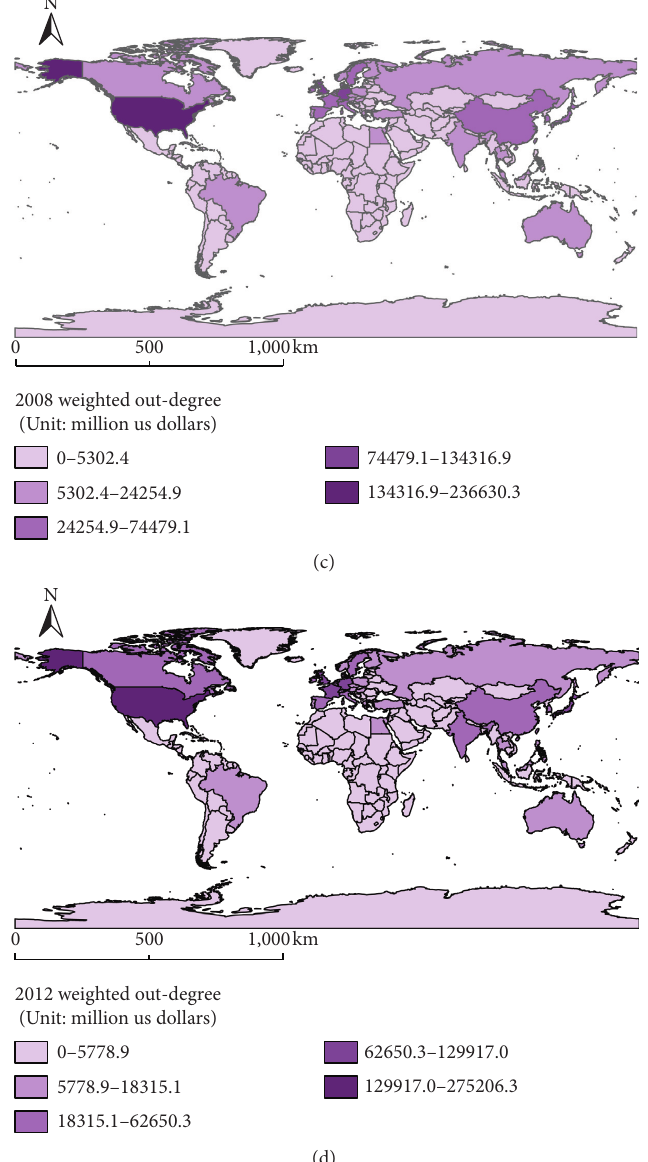
Figure 5: Out-strength spatial distribution of the weighted and directed